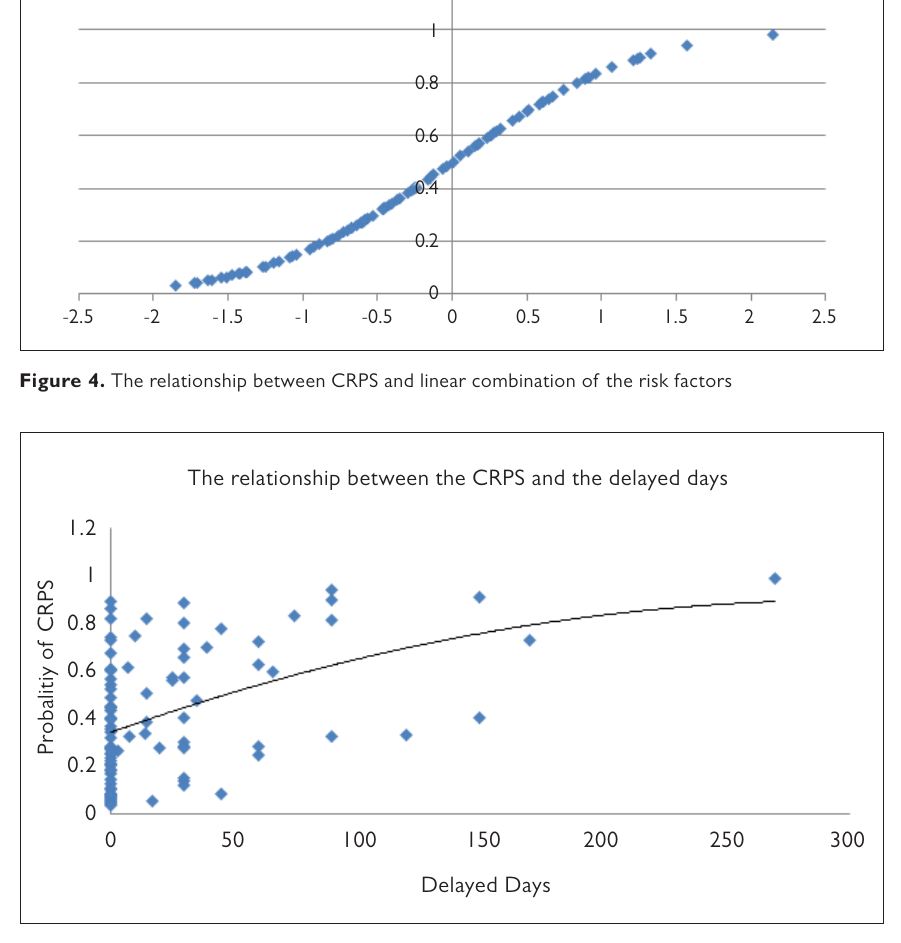
Figure 5. The relationship between CRPS and delayed days